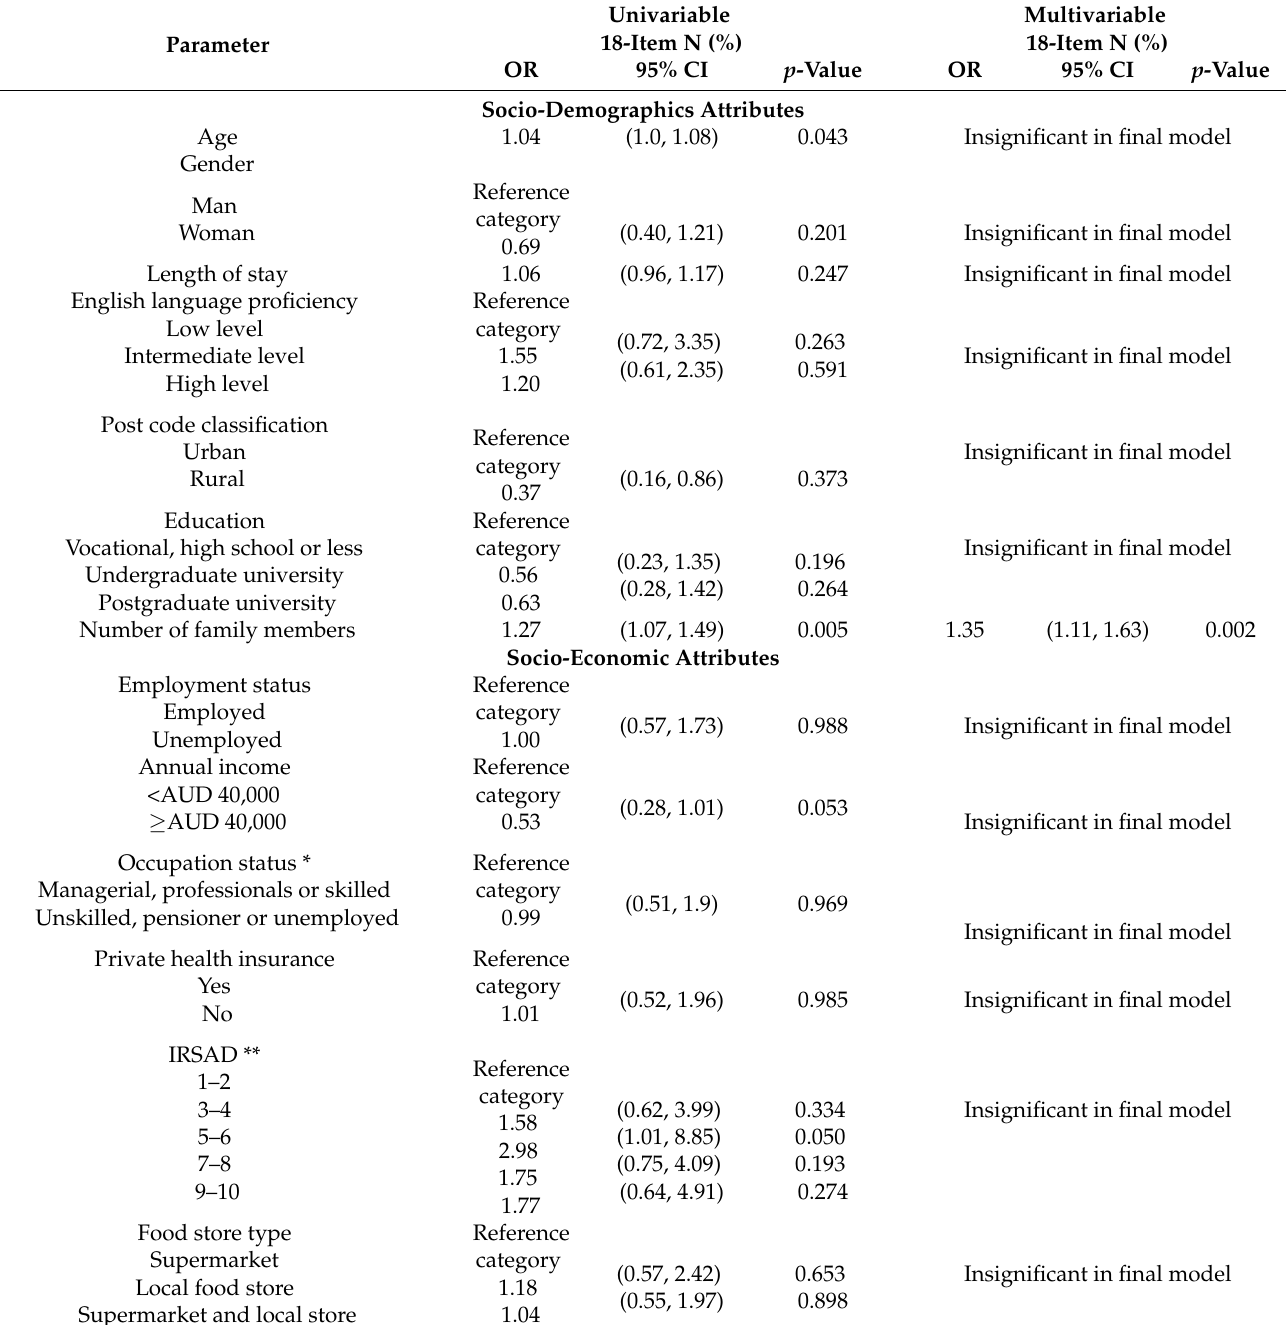
Table 3. Univariable and multivariable logistic regression for the 18-item food insecurity measure—odds ratio (OR) and 95% confidence interval